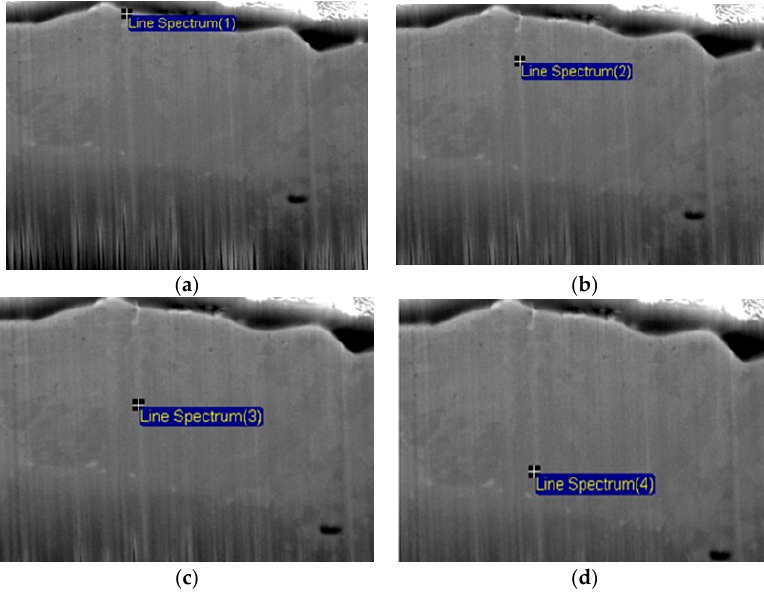
Figure 8. Selected locations over substrate cross section for EDX analysis: ( a ) Sample location 1; ( b ) Sample location 2; ( c ) Sample location 3; ( d ) Sample location 4.